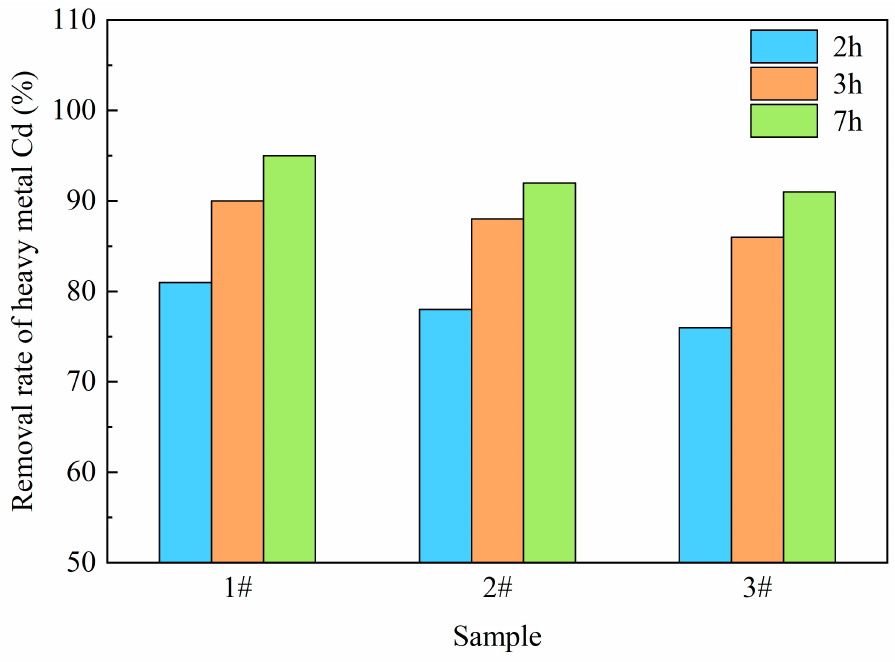
Figure 8. Cd removal rate of different samples under the same conditions.